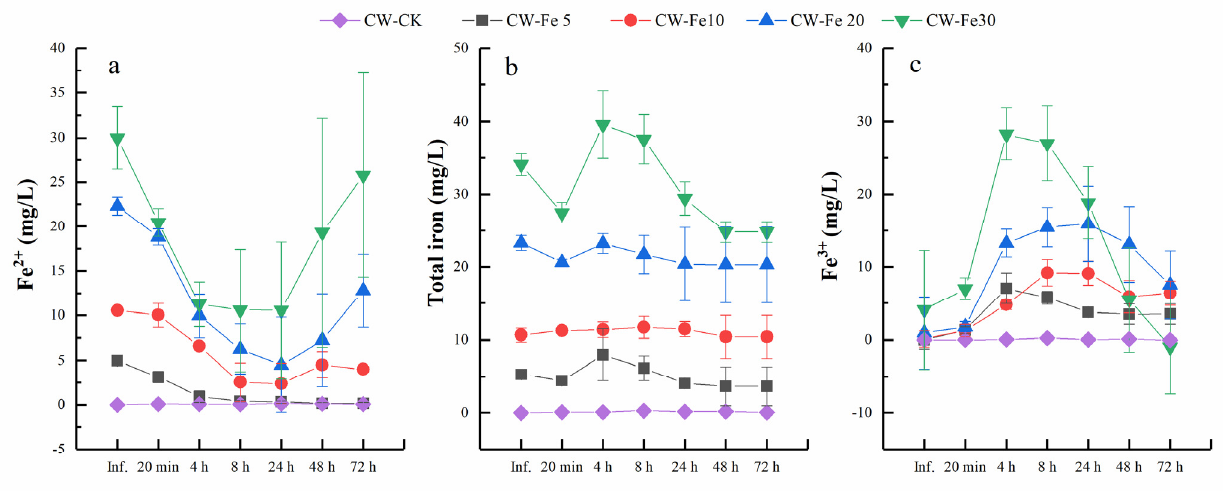
Figure 3. Changes of Fe 2 ( a ), total iron ( b ), and Fe 3+ ( c ) with HRT and influent Fe 2+ concentrations. The pH value (Figure 4) in CW-CK, CW-Fe5, CW-Fe10, CW-Fe20, and CW-Fe30 were 6.95, 6.97, 6.71, 6.35, and 6.84 at 72 h,